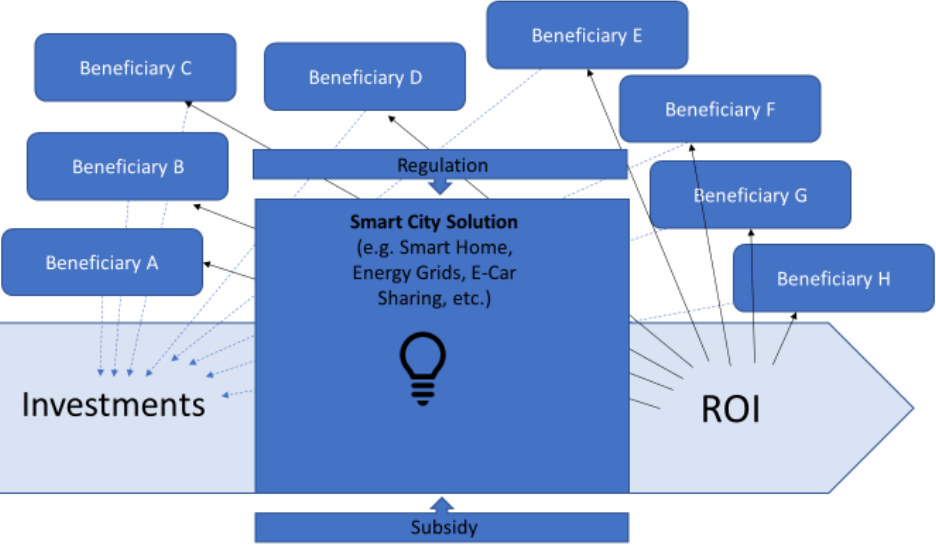
Figure 4. Connected solution and benefits model (Alanus von Radecki).